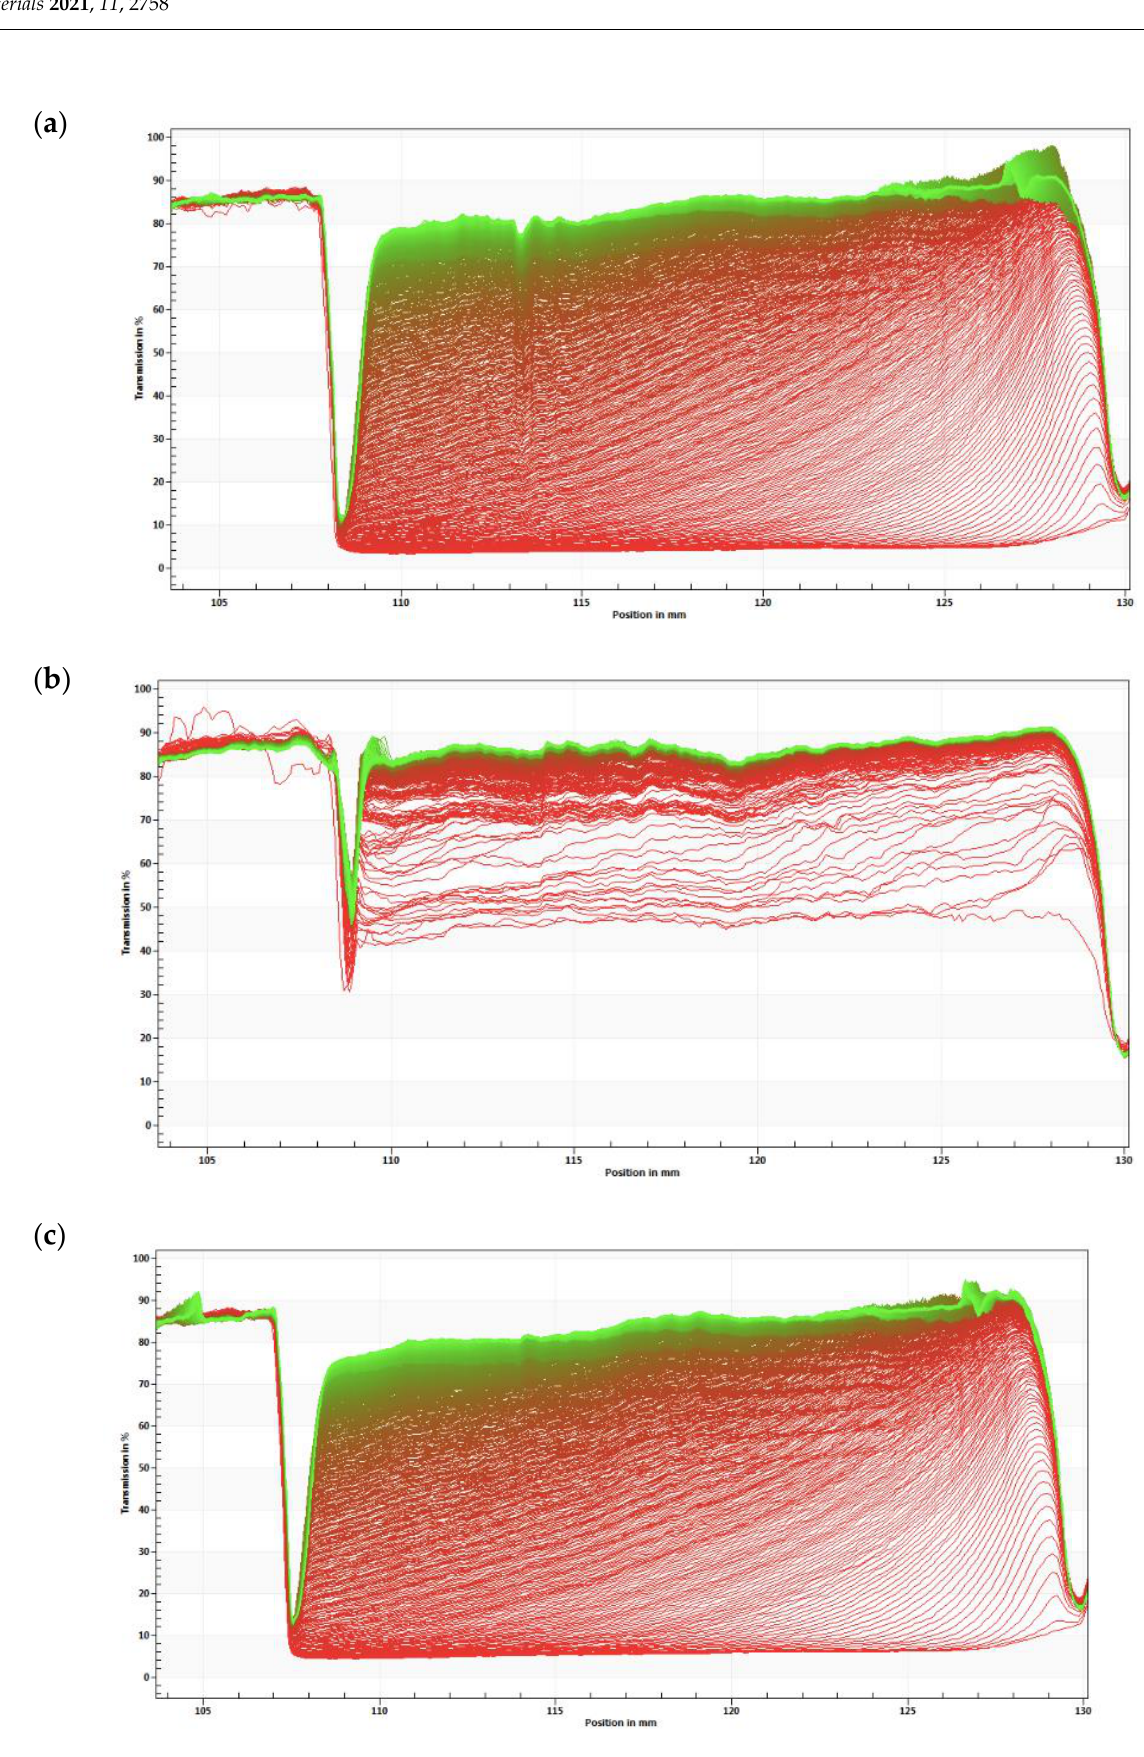
Figure 7. Instability profile of S2-based NE ( a ), S7-based NE ( b ) and CTAB-based nanoemulsion ( c ).